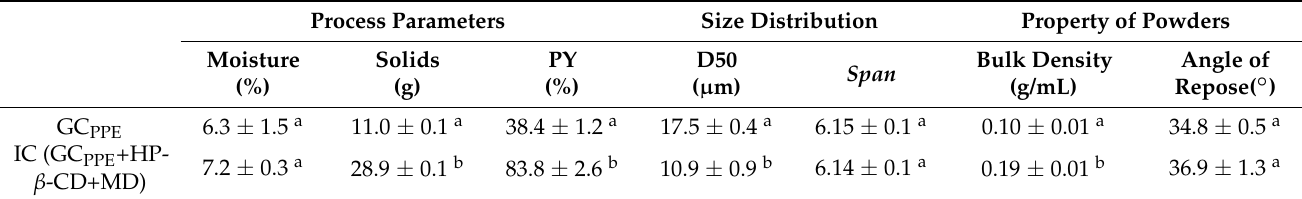
Table 1. Physical characteristics and process parameters for the grape cane phenolic extract (GC PPE ) and inclusion complex (GC PPE +HP- β -CD+MD). Process Parameters Size Distribution Property of